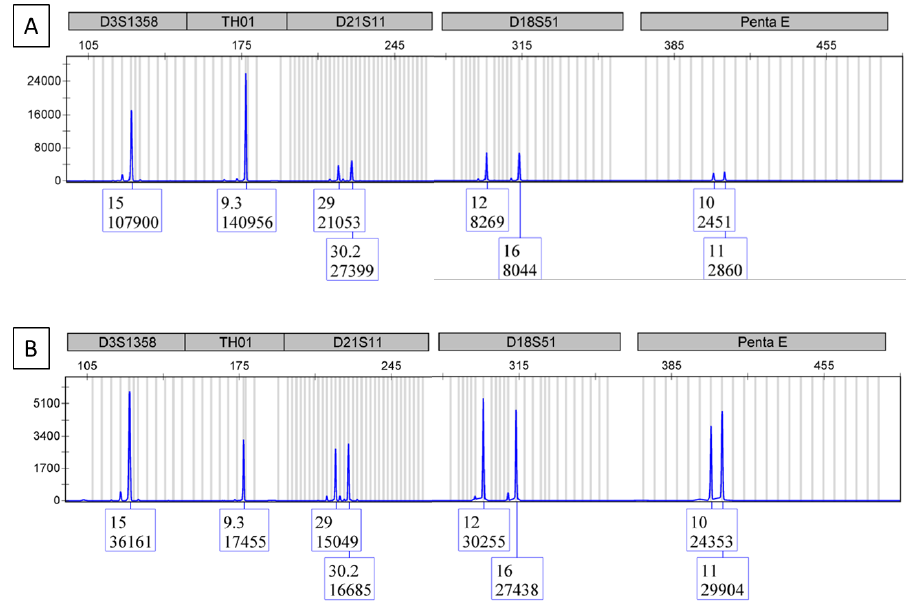
Figure 2. This figure consists of the electropherograms from multiple samples of the same category to protect the DNA fingerprint of any one sample. ( A ) is the DNA fingerprint from the BCR/ABL1 real-time PCR reaction mixture. ( B ) is the DNA fingerprint from the original sample.